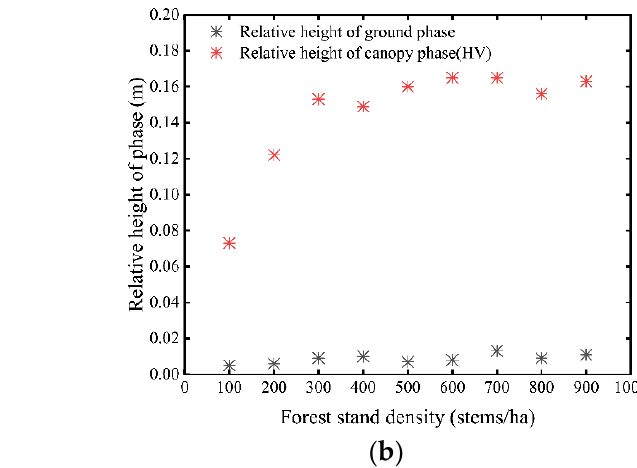
Figure 10. In the SINC inversion method, two ‐ dimensional images of tree height and HV polariza ‐ tion intensity are generated for nine groups of forest stands. ( a ) A two ‐ dimensional map of forest height for nine groups of forest stands. ( b ) A two ‐ dimensional map of the HV magnitude for nine groups of forest stands. For each of the nine groups of forest stands, the black circles indicate the regions with low amplitude values. The red and black circles are positioned in the same location in both images.